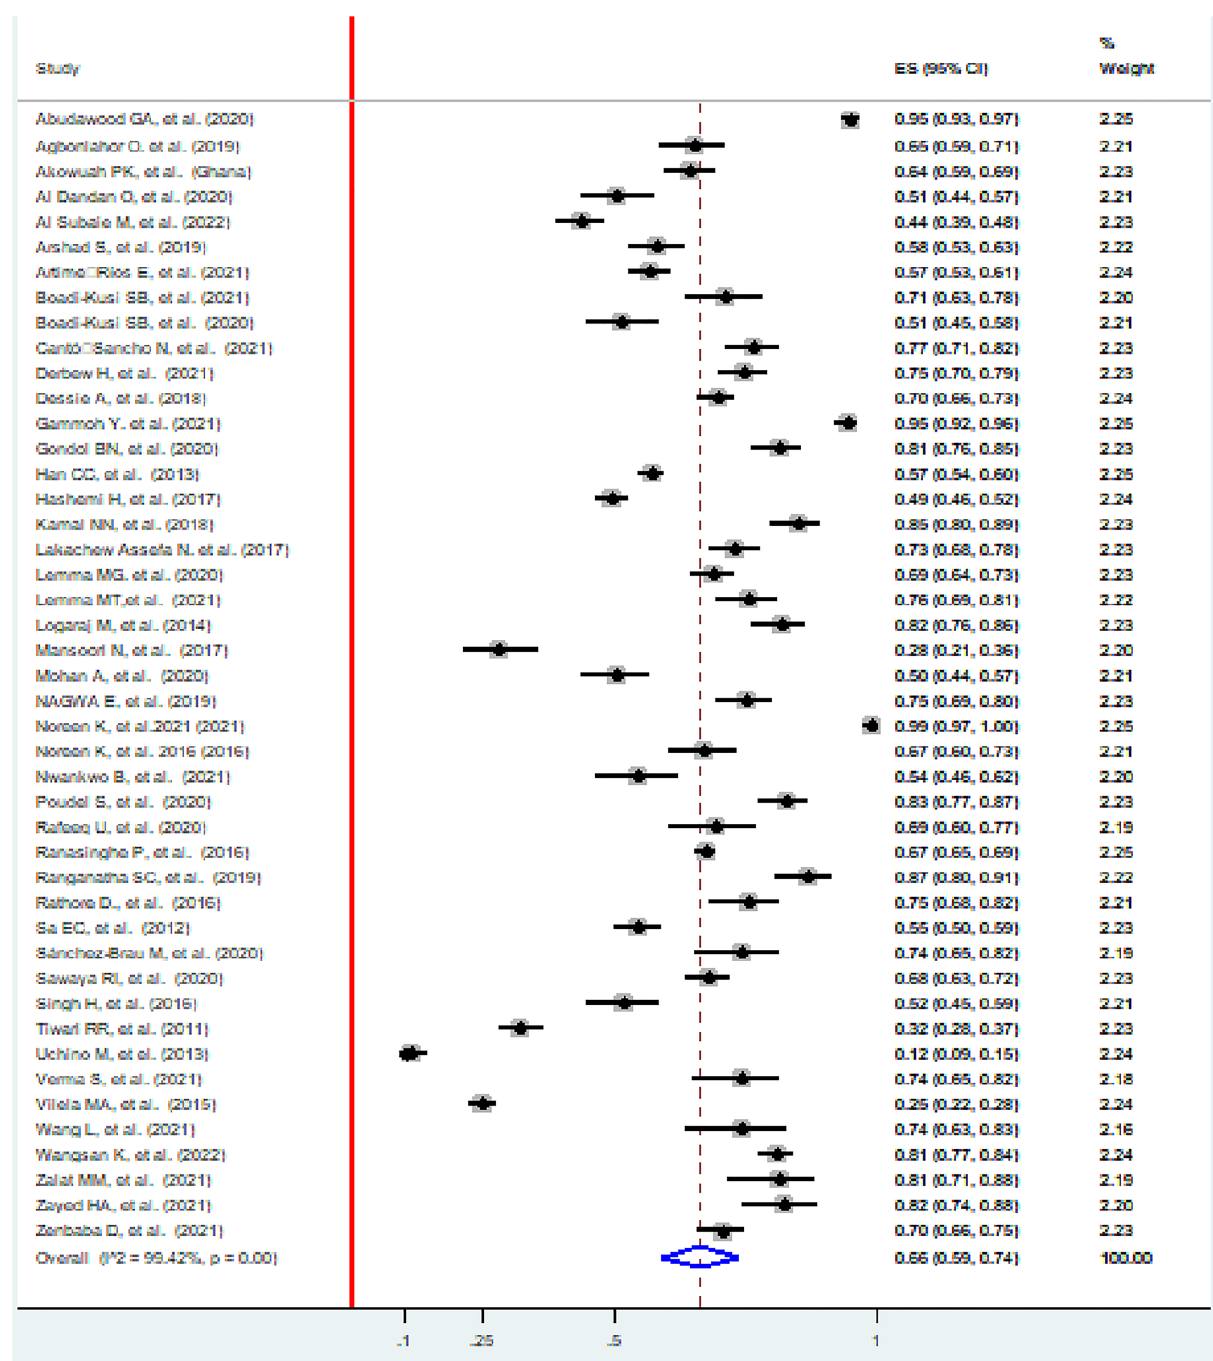
Figure 2. Forest plot showing the pooled prevalence of computer vision syndrome,